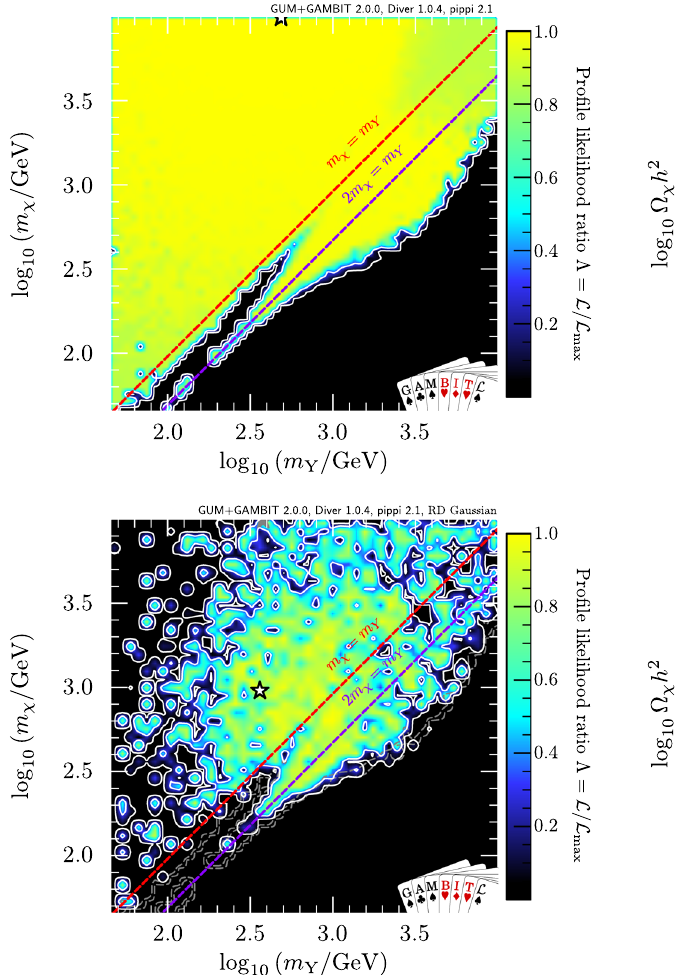
Fig. 1 Profile likelihood in the m χ – m Y plane with the relic density as an upper bound (upper panel) and as an observation (lower panel). Above the red dashed line at m χ = m Y , DM can annihilate into Y bosons. The purple dashed line at 2 m χ = m Y indicates the region where DM can annihilate on resonance. Contour lines show the 1 and 2 σ confidence regions. The white star shows the best-fit point. The grey contours in the lower panel the 1 and 2 σ contours from the upper panel